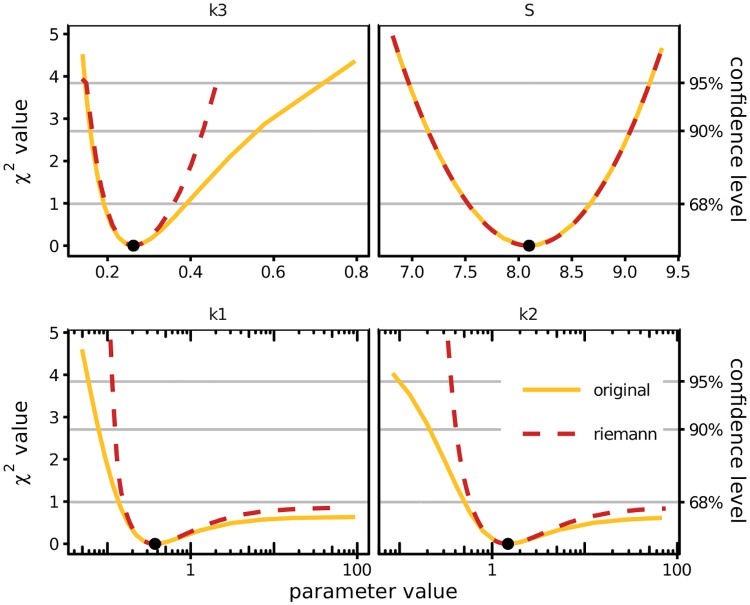
The profile likelihood for the parameter k3 and initial amount S indicates finite confidence intervals according to both, the original (yellow) and Riemann-approximated (red) χ2.The estimated parameter values are depicted as black dots. Practically non-identifiable parameters k1 and k2 do not even exceed the 68% confidence thresholds towards large values, correctly recognized by the approximation.